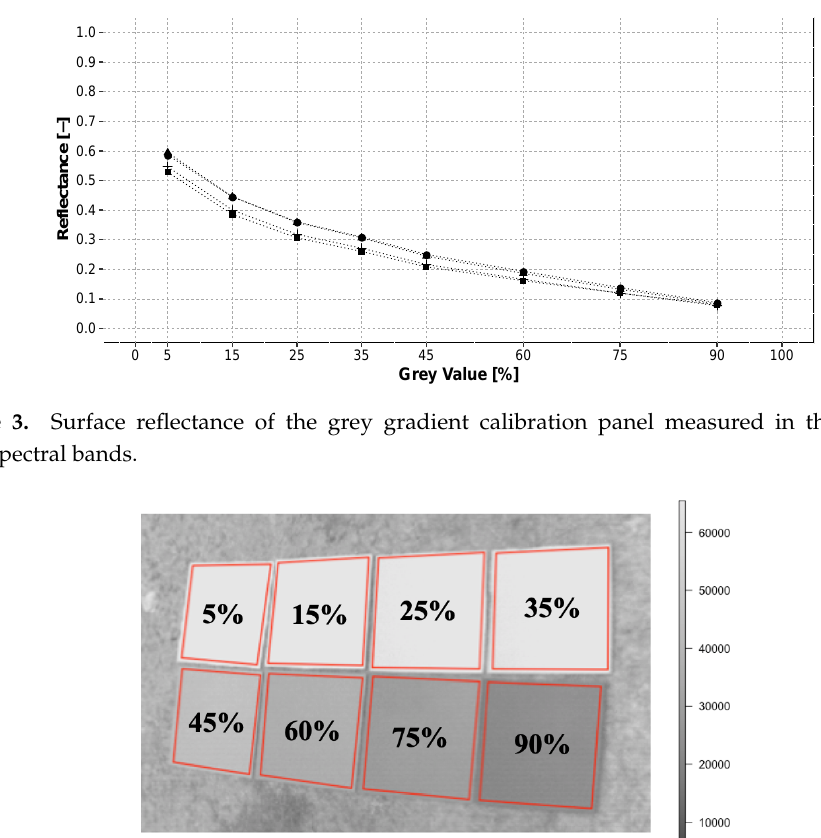
Figure 4. Example of an image used to determine surface reflectance raw DN associated with each grey value. Reference surfaces were delimited and pixel values were extracted using R. Raw DN for one reference surface in one image were calculated as the mean value of corresponding pixels. The standard deviation of all pixel values within one reference surface in one image was negligible in comparison to the mean. The standard deviation of the mean raw DN values for one reference surfaces between images was also negligible in comparison to the mean.